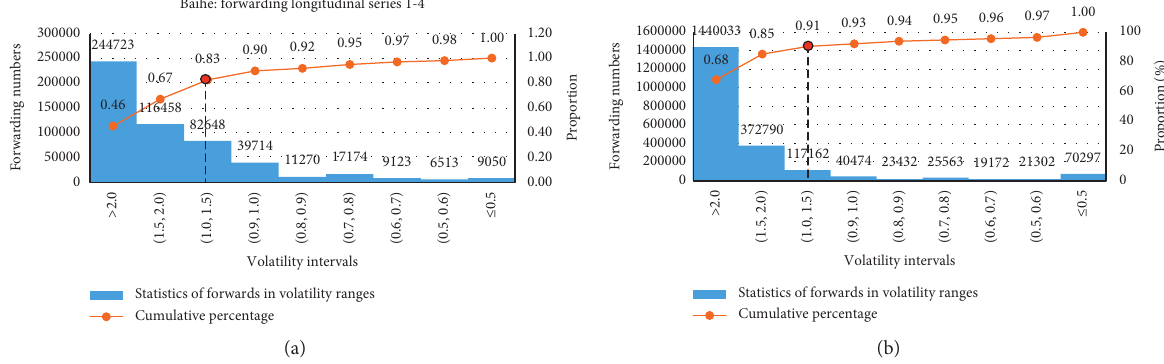
Figure 7: Stationary sequence recognition results on the events Baihe and THAAD. The degree of nonstationarity of the three events is sorted as THAAD (0.91), Baihe (0.83), and Chengdu-Driver (0.78).